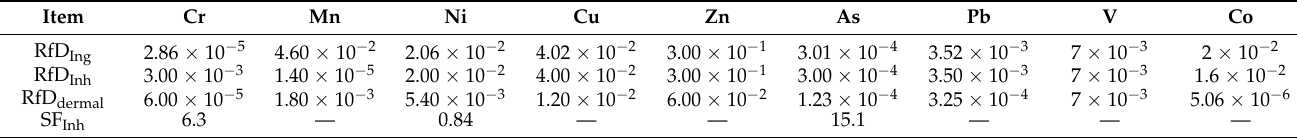
Table 3. Reference dose and slope factor of different exposure pathways of heavy metals (mg · kg − 1 · d − 1 ).